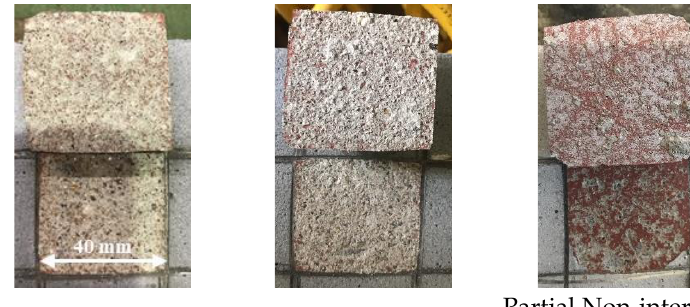
Figure 9. Results of bonding strength tests.